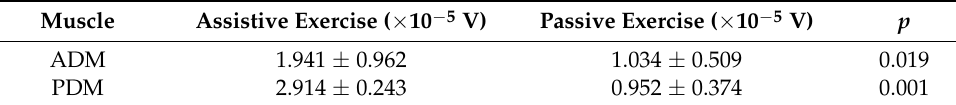
Table 2. RMS of two muscles in two exercise modes.